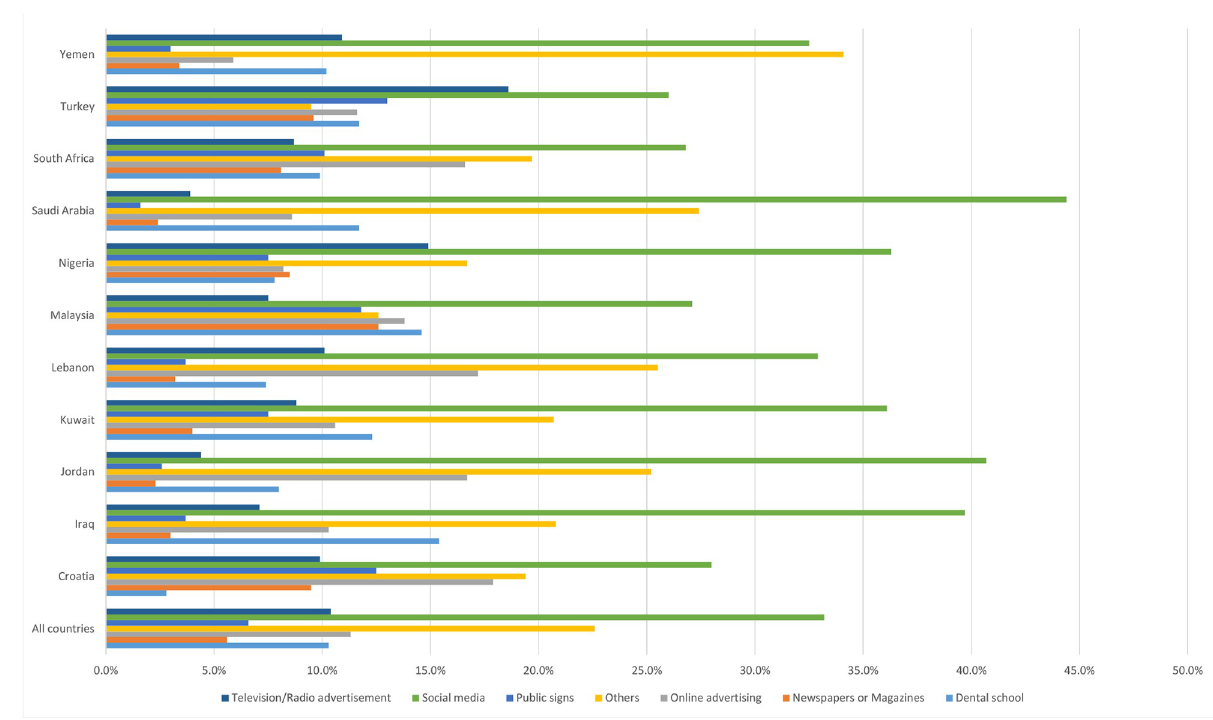
Fig 1. Source of information about